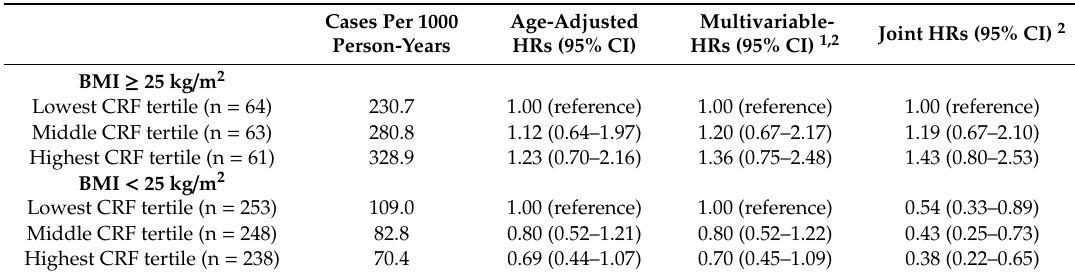
Table 3. Joint analysis of hazard ratios with 95% confidence intervals for the incidence of dyslipidemia based on body mass index and cardiorespiratory